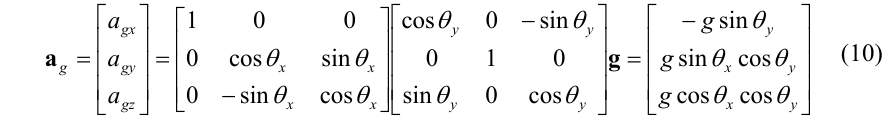
In fact, the actual acceleration is a composition including both of the gravitational and rotational accelerations, which can be obtained as follow without considering noise: